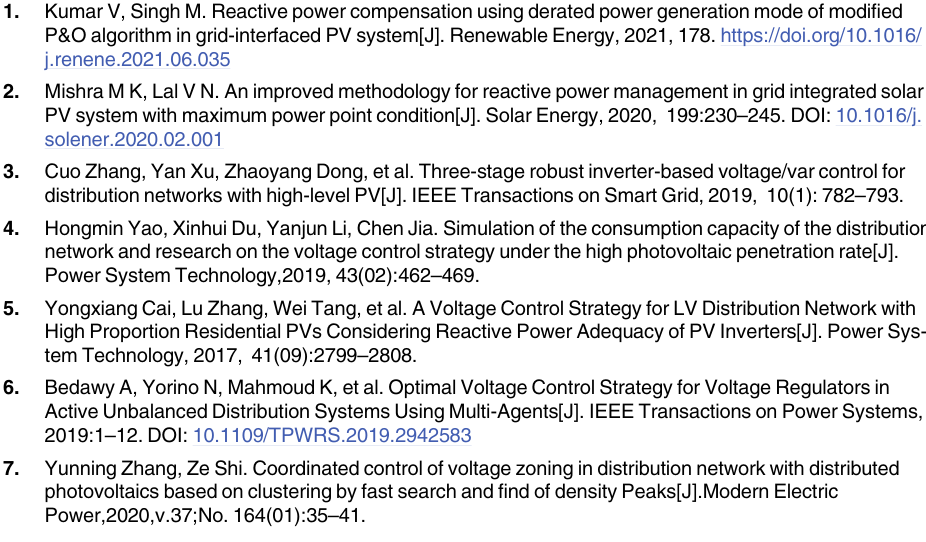
S1 Table. Abbreviated list of